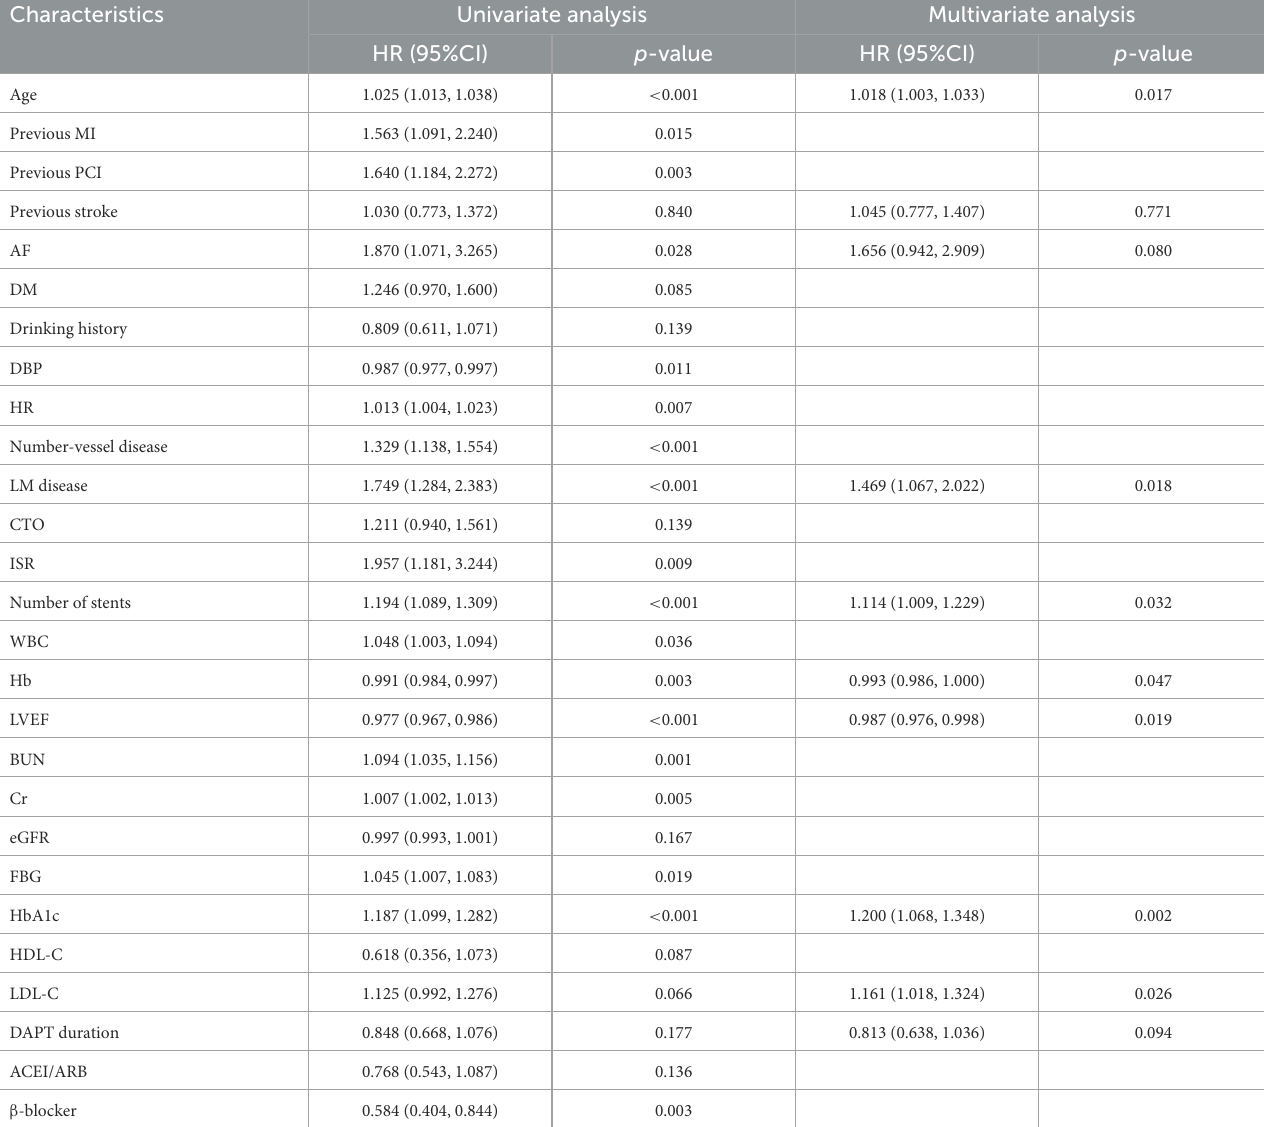
TABLE 3 Predictive value of DAPT duration for MACCE in Cox proportional hazard univariate and multivariate